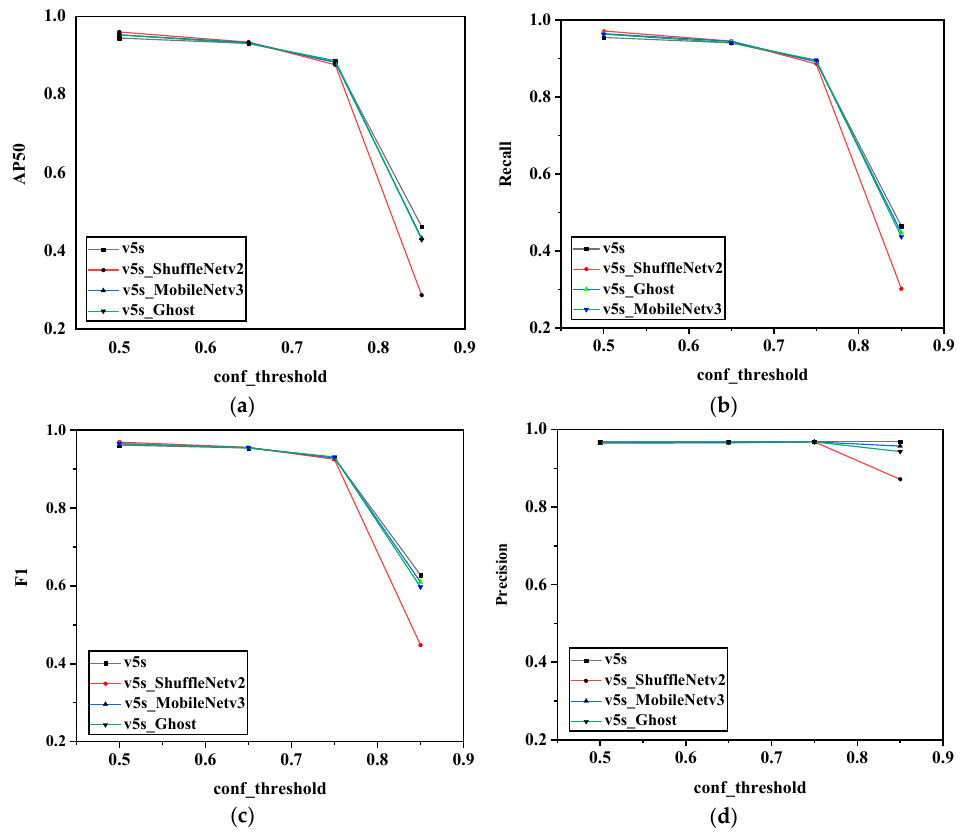
Figure 14. Comparison of test results of different networks (confidence thresholds are 0.5, 0.65, 0.75 and 0.85). ( a ) AP50; ( b ) recall; ( c ) F1; ( d ) precision. Table 4. Comparison results of AP values of different networks with different confidence